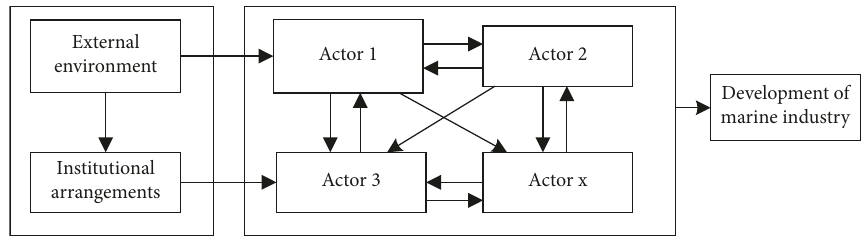
Figure 1: Port space resource